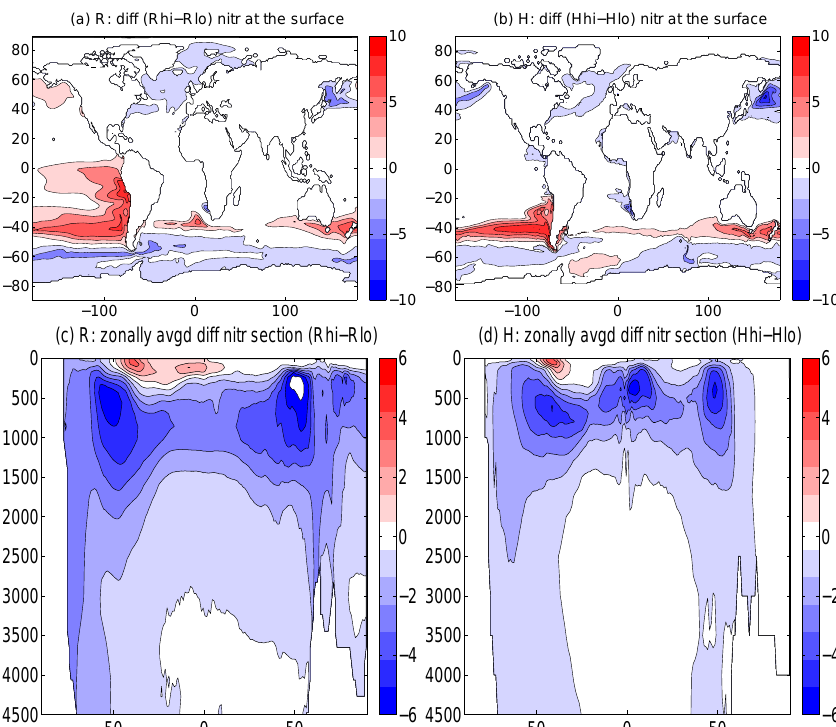
Fig. 6. (a), (b) Surface distributions of δ Nitrate in (a) the GISSER and (b) the GISSEH models at equilibrium. δ Nitrate is defined as the difference between nitrate in the high and the low remineralization cases. Units are in mmolNm − 3 . (c), (d) Zonally averaged vertical sections of δ nitrate defined as the difference in nitrate between high and low remineralization rates in the (a) GISSER and (b) GISSEH models. Units are in mmolNm − 3 .